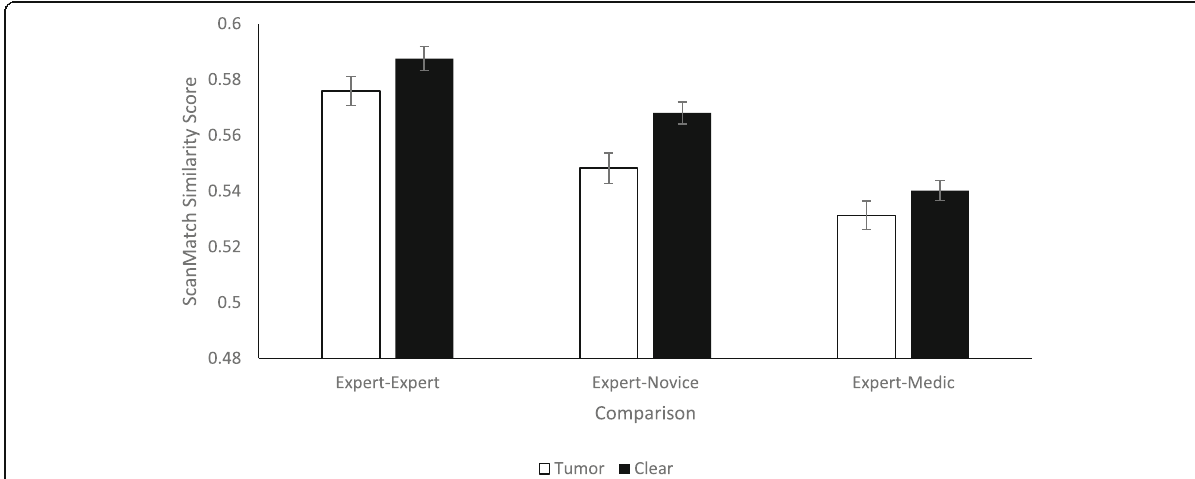
Fig. 6 Interaction between between-group comparison and diagnosis on ScanMatch similarity score when Experts are the reference group. Error bars represent standard